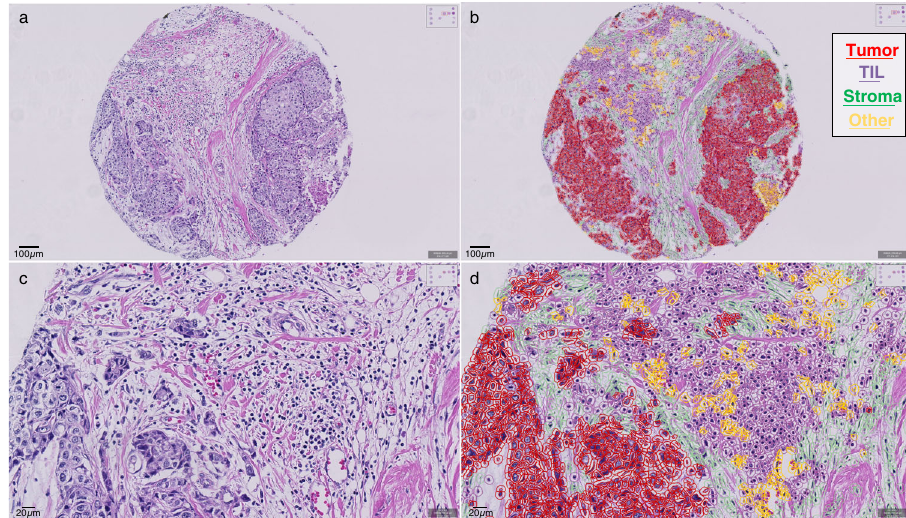
Fig. 2 TILs manual and digital evaluation. Representative image of a tissue-microarray (TMA) core ( a and c, original magni fi cation x200 and x400, respectively); Digital image analysis and different cell type annotations in the same images, using a machine-learning algorithm ( b and d, original magni fi cation x200 and x400,